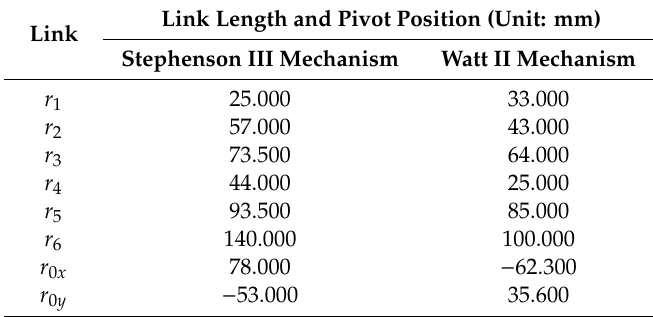
Table 3. Dimensions of the initially designed VCR engine mechanisms.